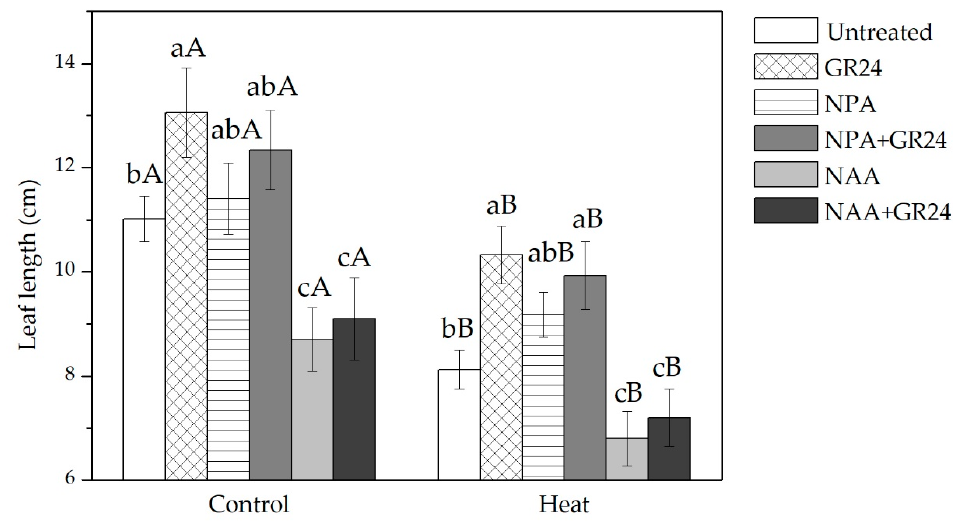
Figure 1. Leaf length of plants under each treatment. Lowercase letters are for comparison between different chemical treatments, and uppercase letters are for comparison between treatments under two temperature conditions.